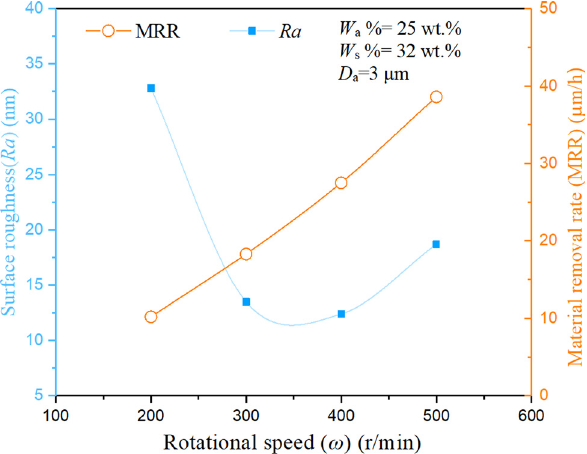
Figure 6: E ff ect of self - rotational speed of workpieces ω on the polishing data of Ra and